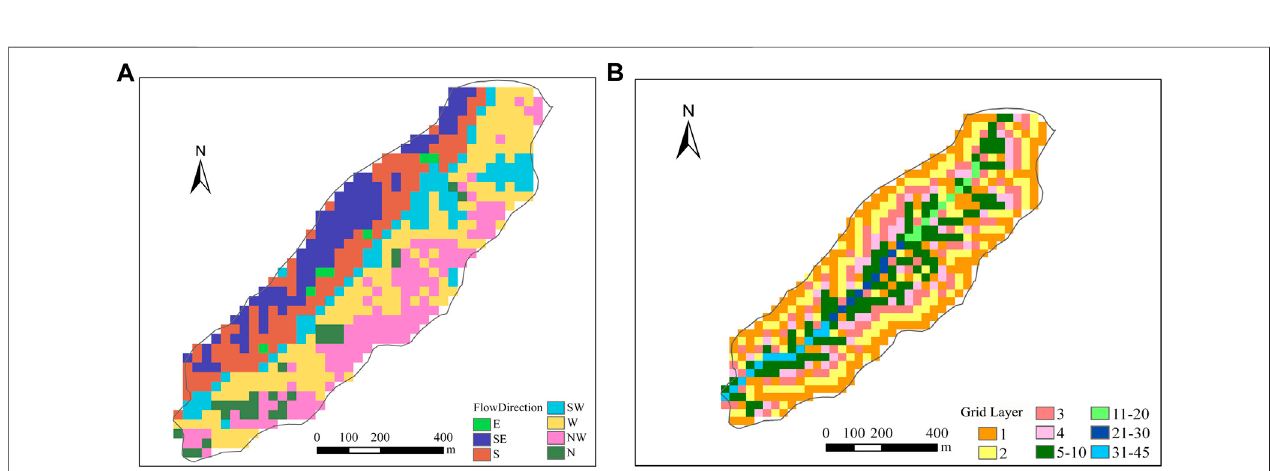
FIGURE 4 | Flow direction (A) and prioritization of grid cells (B) in Kendall watershed.